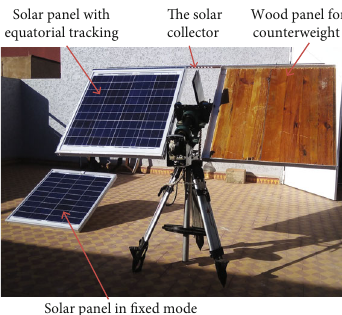
Figure 44: The solar panel on the right in the tracking mode, the one on the left in the fi xed mode.